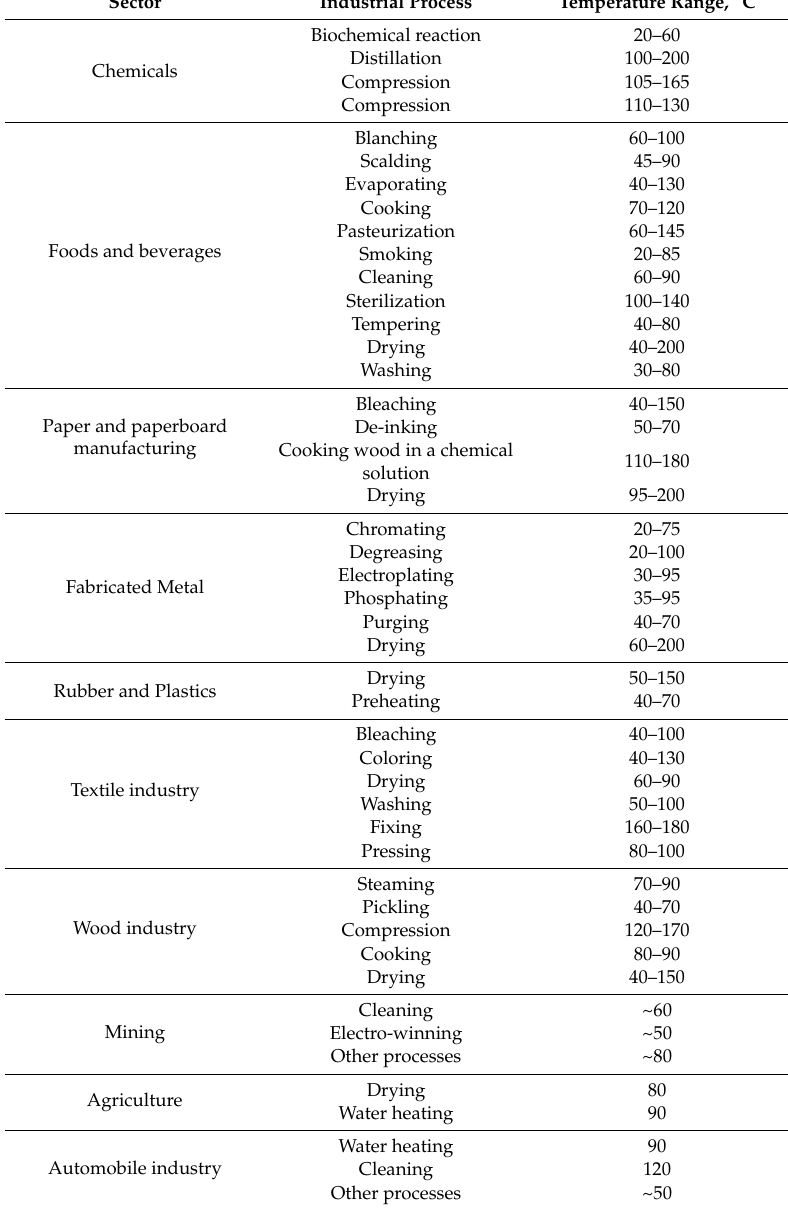
Table 1. Industrial processes are potentially suitable for the use of solar collectors as heat supply equipment